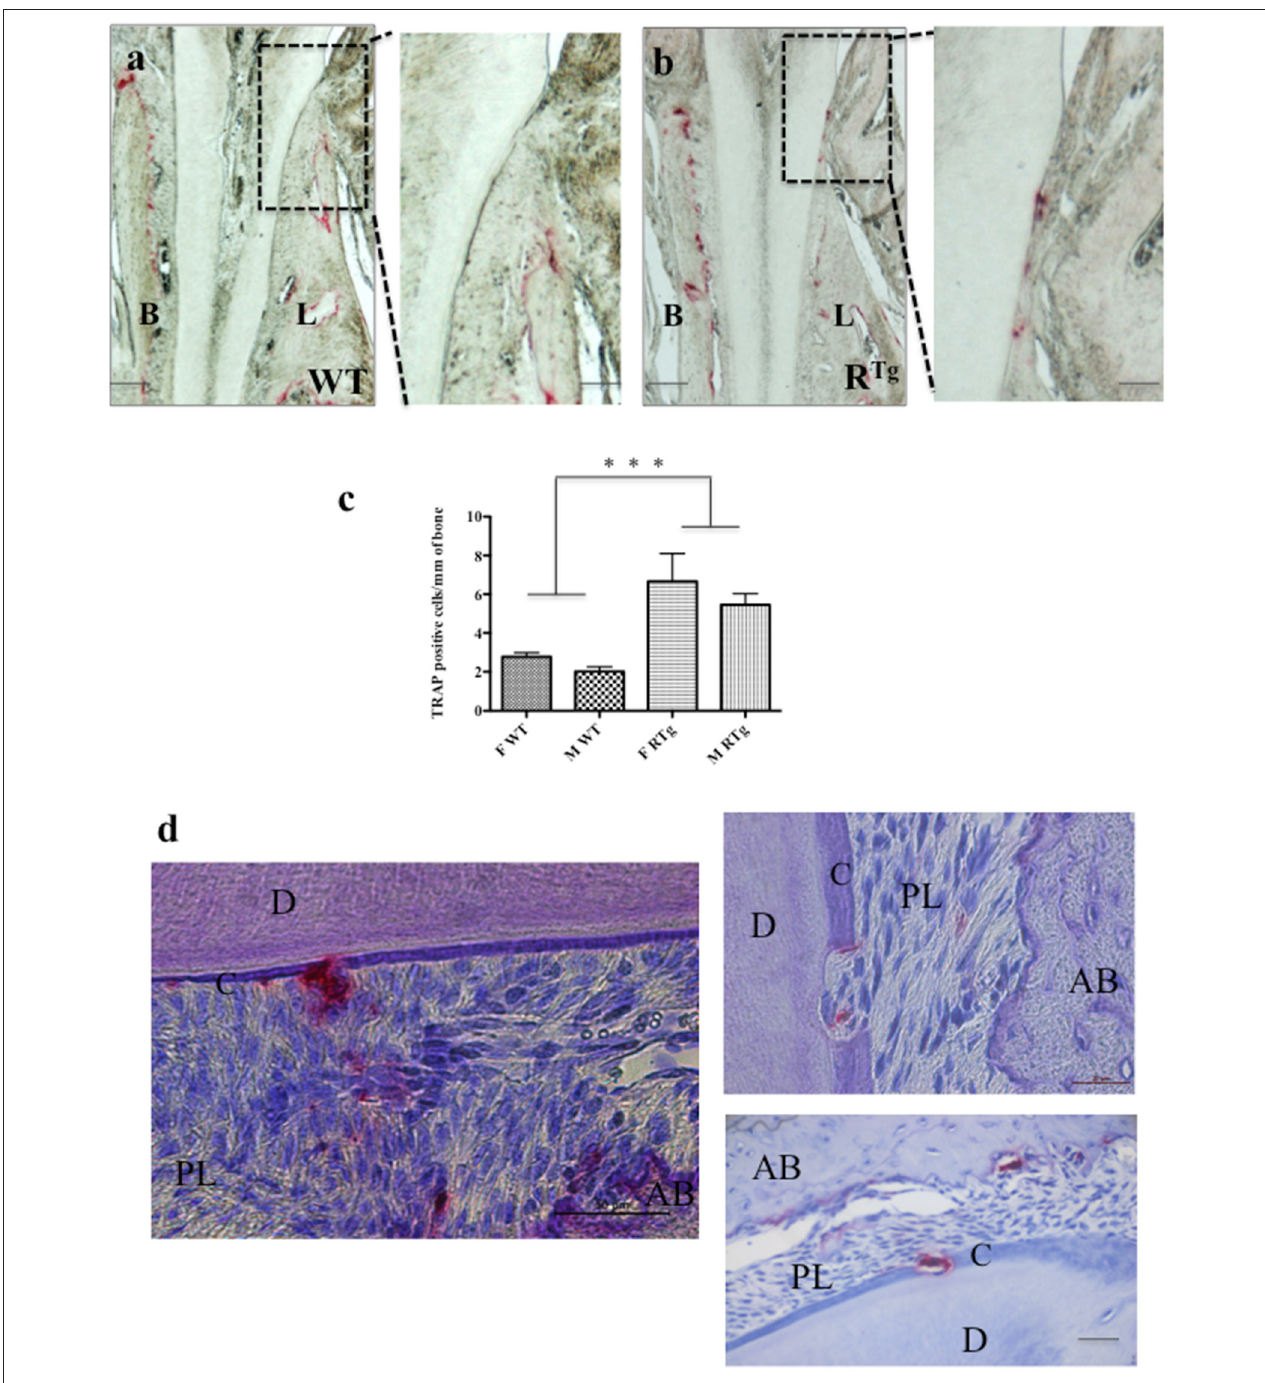
FIGURE 2 | TRAP positive cells in 5-month-old mice. TRAP histo-enzymology performed on frontal sections (a,b) enabled visualization of a large increase in the number of TRAP positive cells (red staining) on both buccal (B) and lingual (L) surfaces of the alveolar bone of R Tg mice ( n = 10) relative to that of WT mice ( n = 10). Magnifications of the lingual cervical dentin region (dashed rectangles in a,b ) showed the presence of numerous TRAP positive cells on the dentin surface, almost exclusively in R Tg mice. Quantification of TRAP-positive cells (C) on alveolar bone surfaces of WT and R Tg females (in green) and males (blue) showed a significantly (*** p < 0.001) higher number of cells respectively in both male (M) and female (F) R Tg mice than in WT mice. Similar numbers of TRAP positive cells were visible at the cementum surface and in resorption lacunas through the cementum and dentin (d) in the root area of R Tg mice. AB, alveolar bone; D, dentin; C, cementum; PL, periodontal ligament. Scale bars correspond to 10 µ m in a,b , 20 µ m in the enlarged a,b and right photograph in d , and 50 µ m in the left photograph in d .